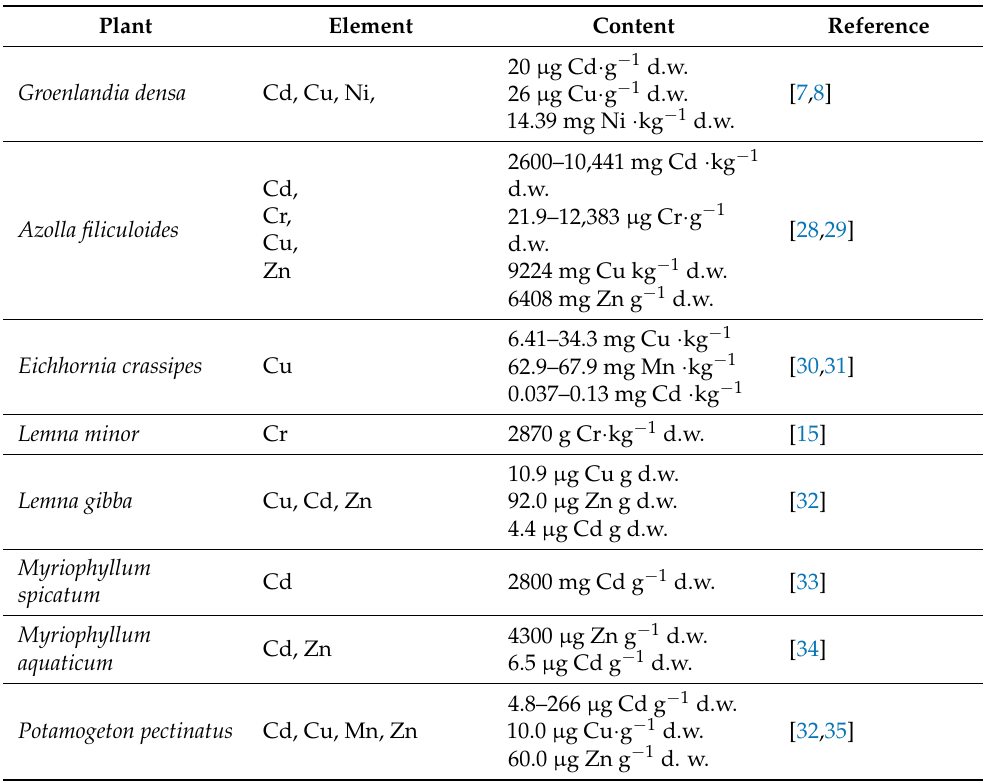
Table 5. Comparison of trace element content in G. densa with other aquatic plants. Plant